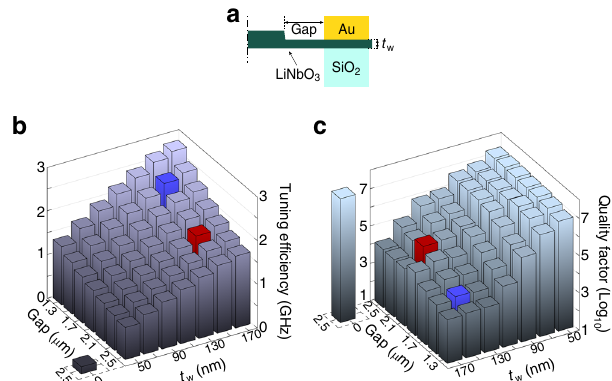
Fig. 8 Numerical modeling of electro-optic coupling. a Schematic of half of the cross-section of the EOM structure. “ Gap ” denotes the spacing between the gold electrode and the LN cavity, and “ t w ” denotes the thickness of the waveguide wing layer. b, c Electro-optic tuning ef fi ciency and optical quality factor of the device as a function of Gap and t w , simulated by the FEM method. The red column represents the parameter design used for the EOMs demonstrated in the main text. The blue column shows another design with broader bandwidth and enhanced electro-optic coupling. The individual column at the left of each plot indicates the case when t w = 0 μ m and gap = 2.5 μ m, for a device with full surrounding air